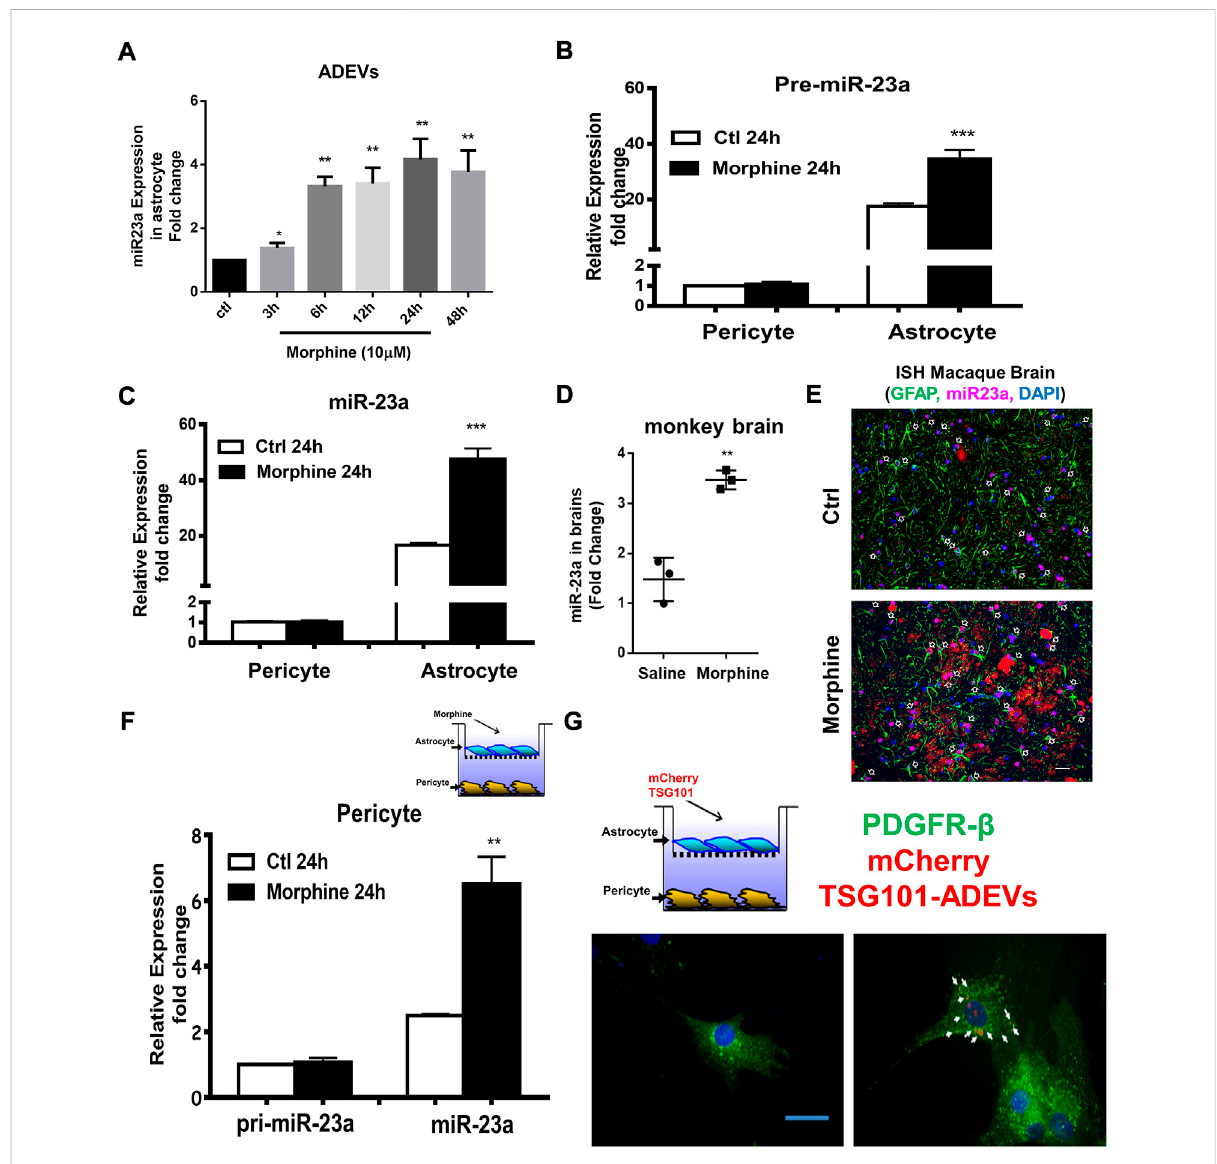
time PCR. (B,C) Pericytes and astrocytes were treated with or without morphine for 24 h, followed by an assessment of pre- (B) or mature-miR-23a (C) expression using real-time PCR. (D,E) miR-23a was up-regulated in the brains of morphine-dependent macaques as assessed by (D) real- time PCR and, (E) in situ hybridization. (F) Exposure of astrocytes to morphine for 24 h, followed by coculturing with pericyte for an additional 24 h. Then extracted RNA from pericytes, followed by an assessment of pre- or mature-miR-23a in the pericytes. (G) mouse primary astrocytes